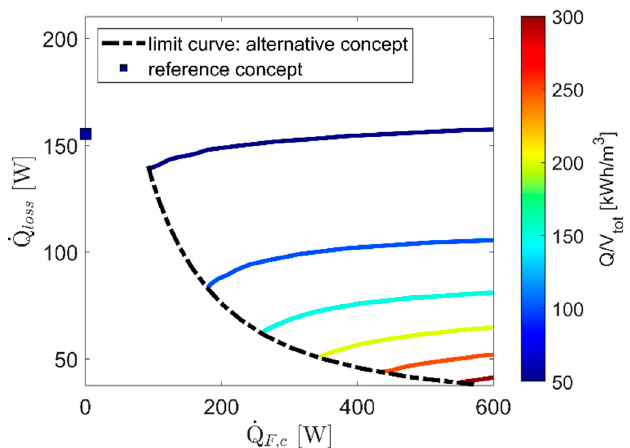
Figure 9. Heat losses ( 𝑄(cid:4662) (cid:3039)(cid:3042)(cid:3046)(cid:3046) ) and volumetric systemic storage densities of the reference and the alternative concept as a function of the resulting thermal cooling powers ( 𝑄(cid:4662) (cid:3007),(cid:3030) ).